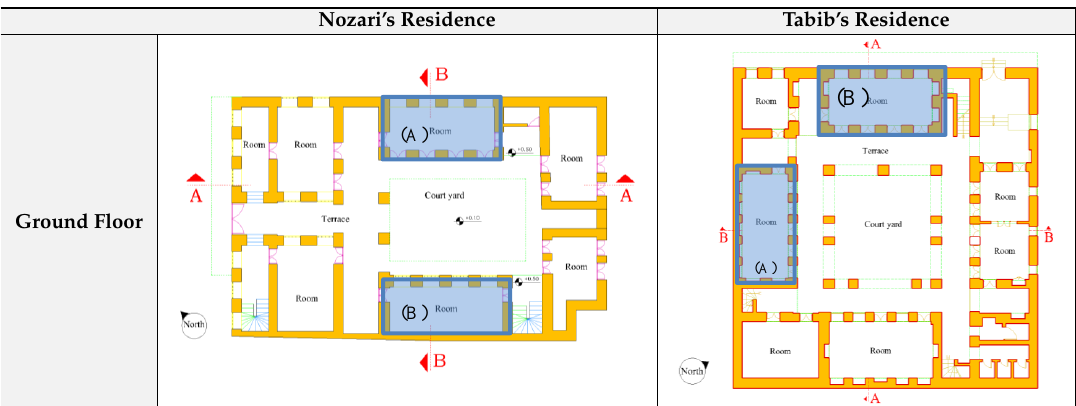
Figure 10. Sensors and data loggers used for the data collection.